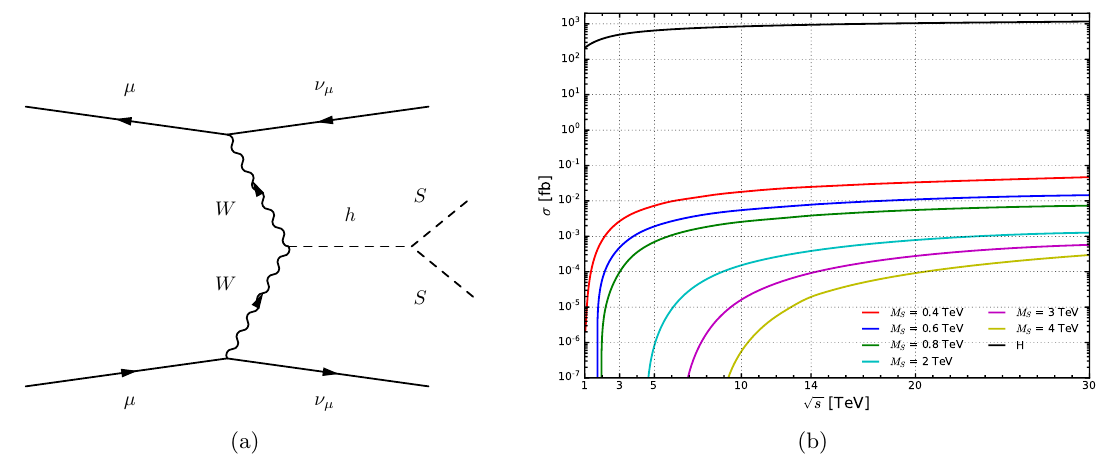
Figure 9 . (a) Diagrammatic representation of SS pair production through W + W (cid:0) fusion in a scalar singlet extension of the SM. (b) SS pair production cross section [fb] via EW VBF in (cid:22) + (cid:22) (cid:0) p collisions as a function of collider energy s [TeV] for representative coupling inputs. Also shown for comparison is the H production process via EW VBF (black curve) in the